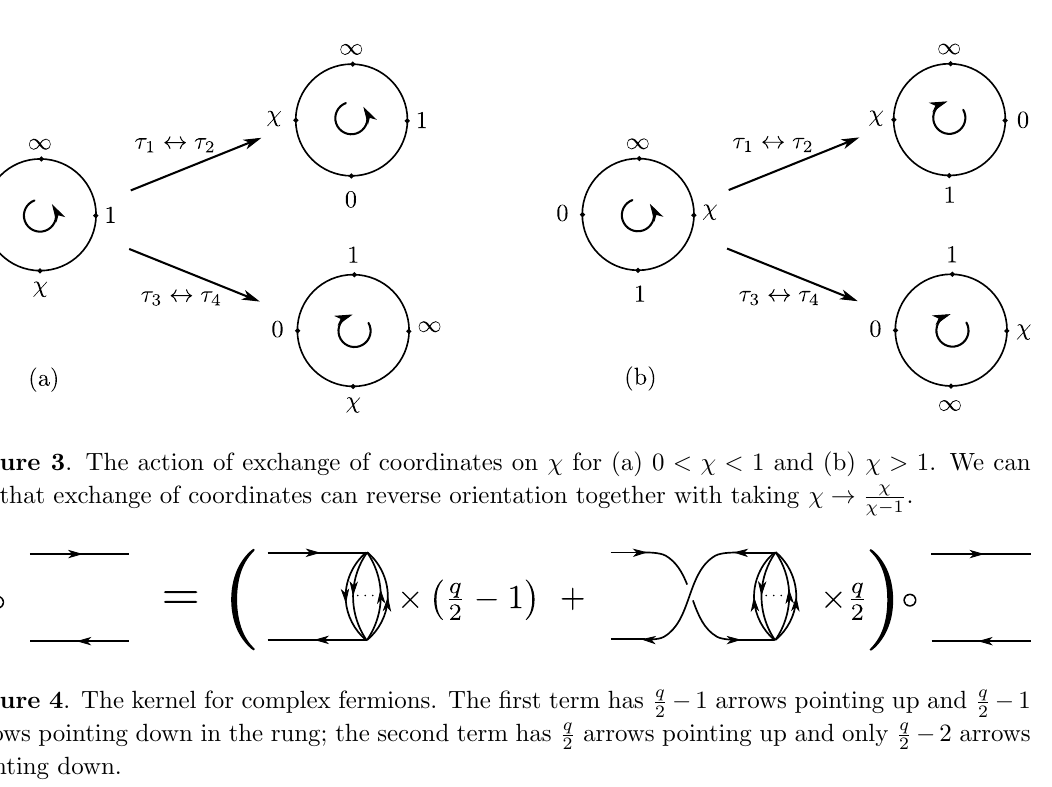
(cid:0) 1 arrows pointing up and q 2 arrows pointing up and only q 2